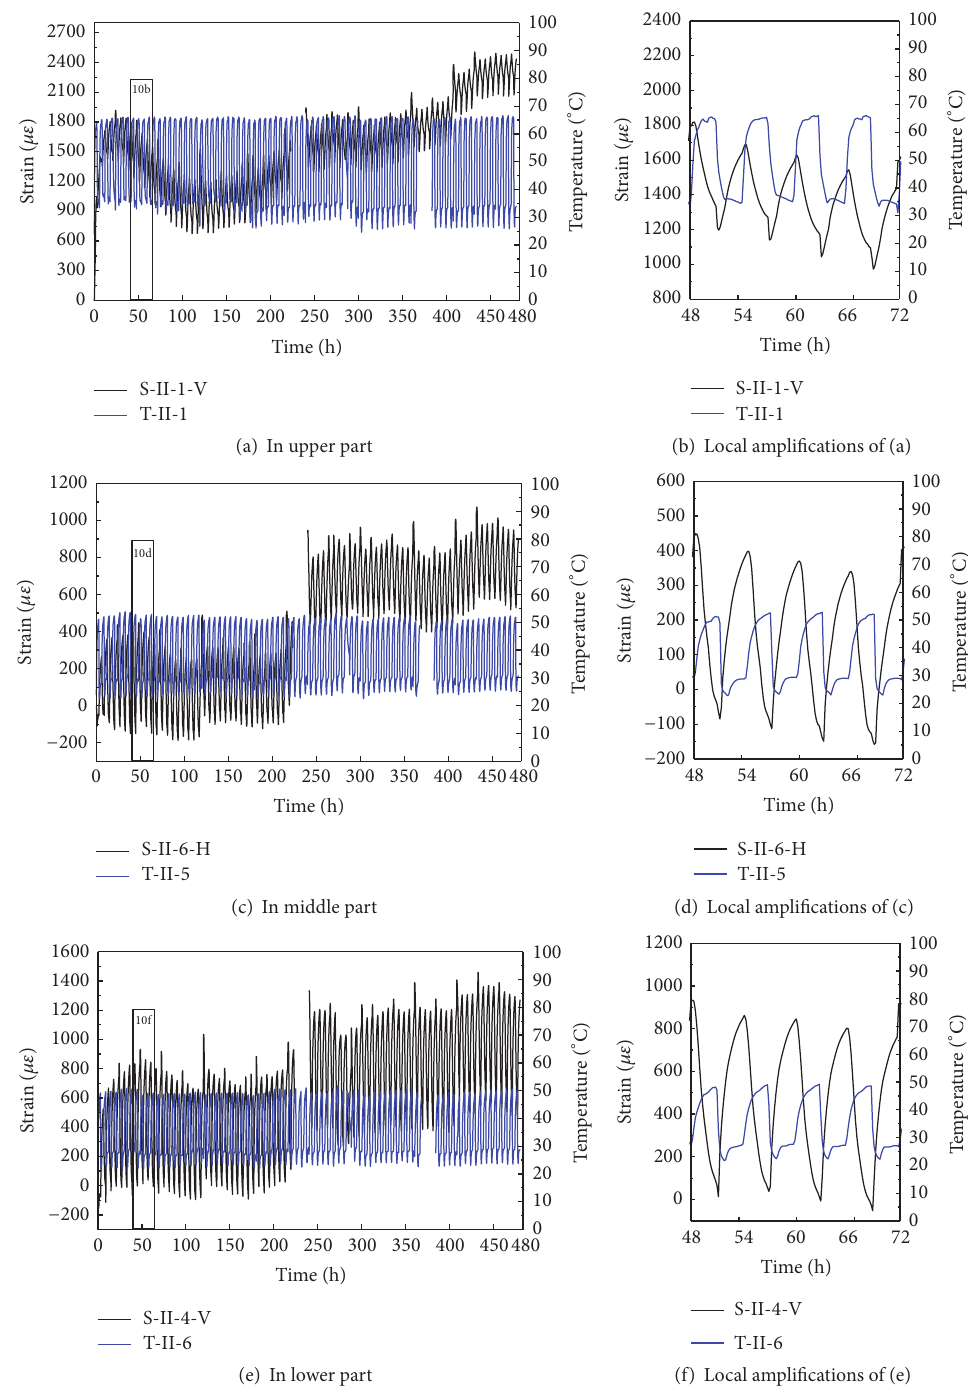
Figure 10: Strain-time-temperature relationship of insulating layer.